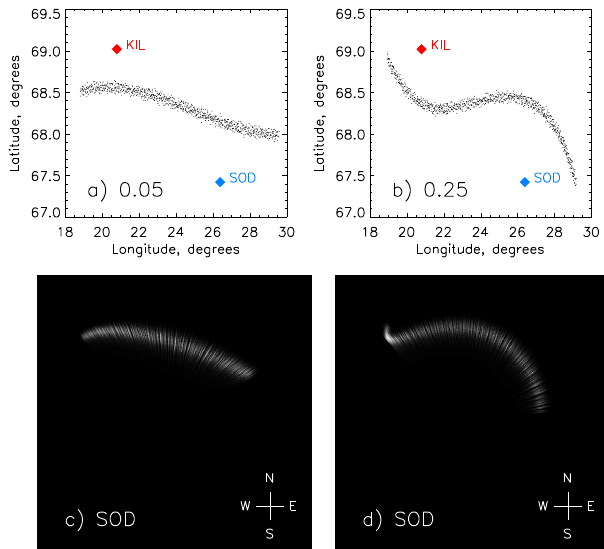
Fig. 7. (a) Ray footprints for a simulated arc with bendiness 0.05. Fig. 7. a) Ray footprints for a simulated arc with bendiness 0.05. b) Ray footprints for a simu- (b) Ray footprints for a simulated arc with bendiness 0.25. Pan- lated arc with bendiness 0.25. Panels c) and d) show the arcs in panels a) and b) respectively, els (c) and (d) show the arcs in panels (a) and (b) respectively, as as viewed from Sodankyl¨a. viewed from 30